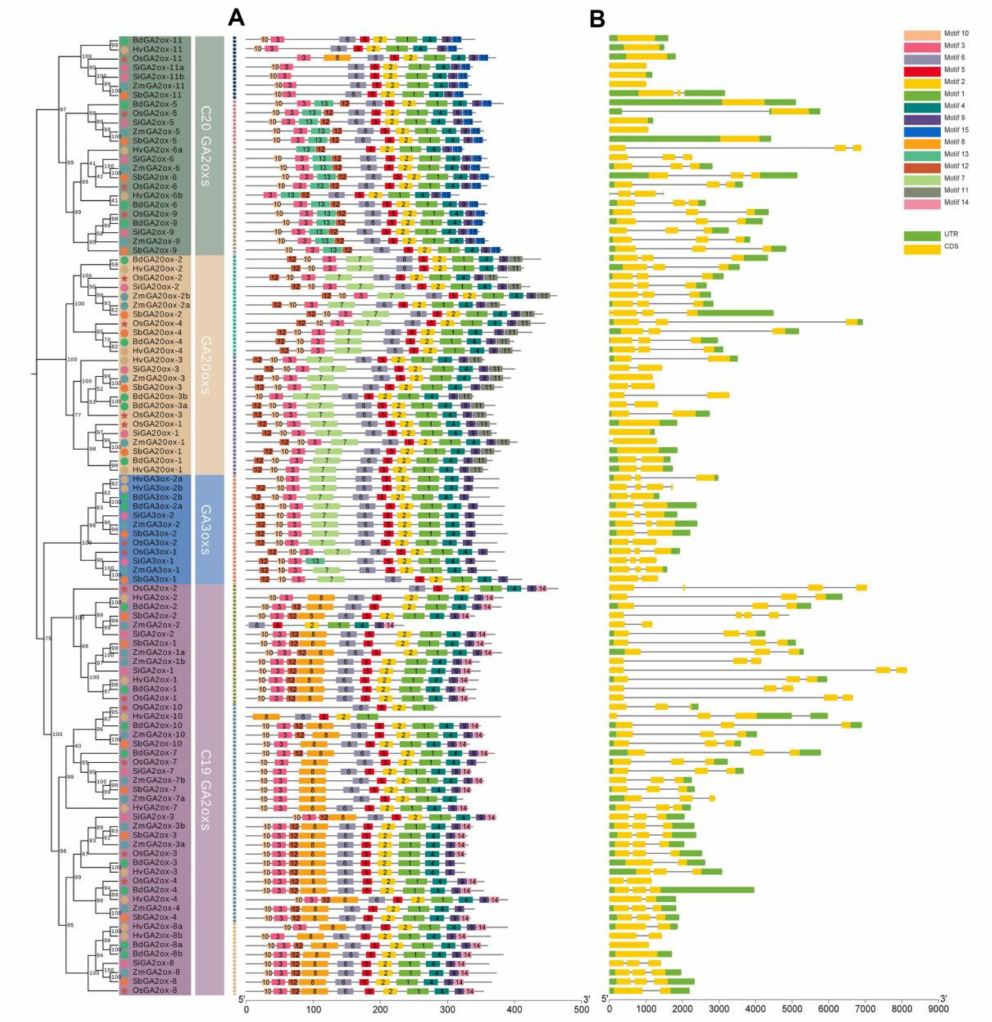
Figure 3. Phylogenetic tree, gene structure, and conserved motif analysis of GAox genes in six plants. ( A ) Conserved motif analysis, where the different colored boxes represent different motifs. ( B ) Gene structure analysis, where the green and yellow boxes represent UTR and exons, separately, and introns are displayed by gray